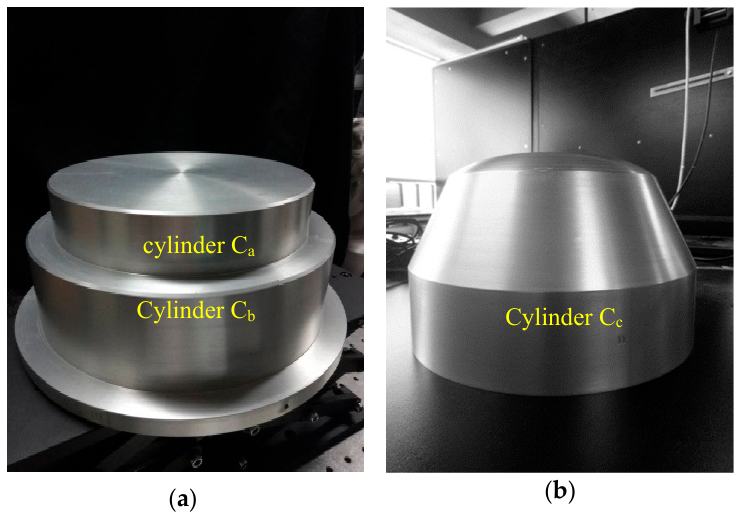
Figure 9. HDR objects. ( a ) Stepped cylinder object with cylinder Ca and Cb; ( b ) cylindrical shell object with cylinder Cc.